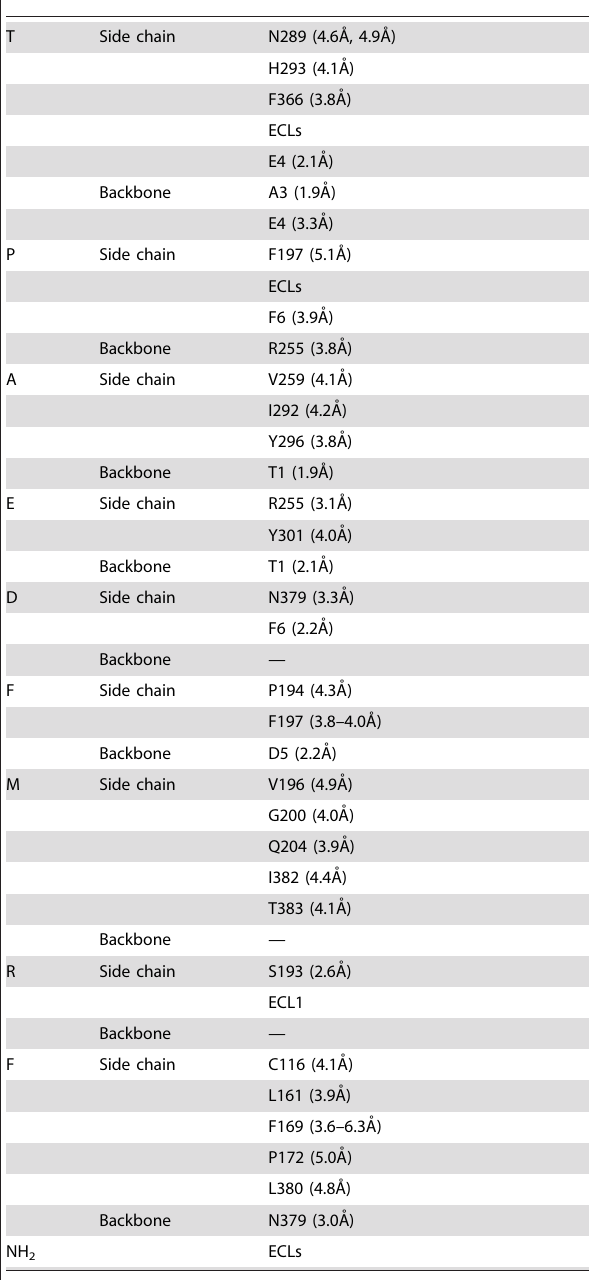
Table 11. TPAEDFMRF-NH 2 ligand-receptor contact sites a